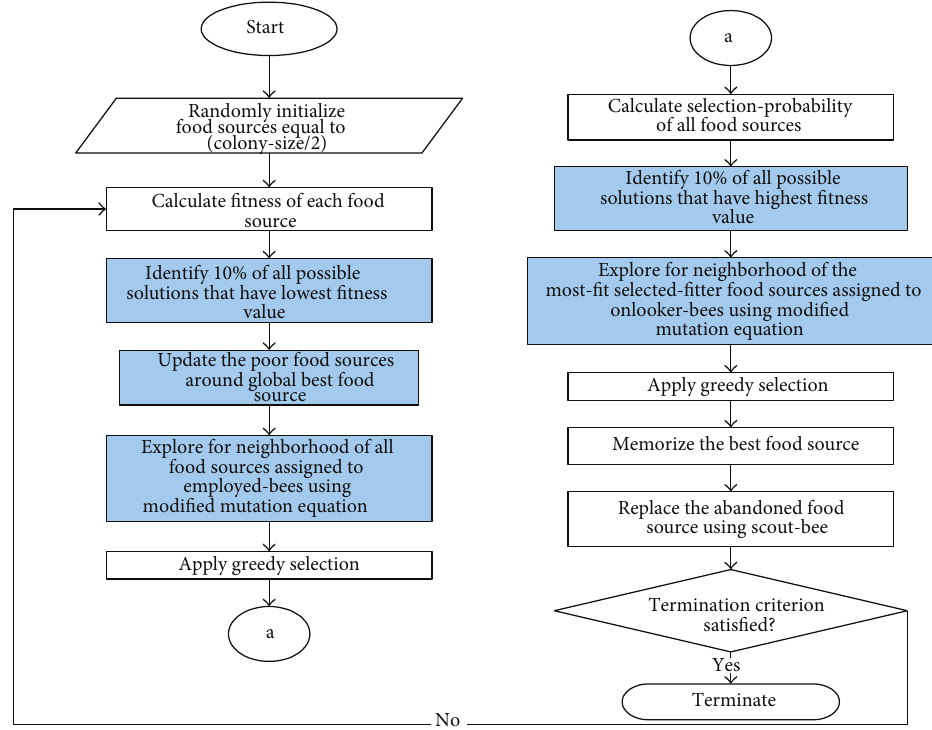
Figure 2: The flowchart of new enhanced ABC (JA-ABC5)